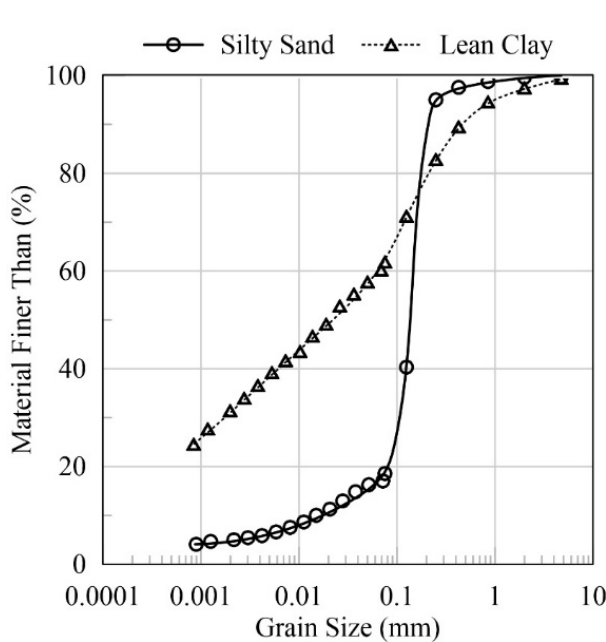
Figure 2. Grain size distributions of the investigated soils.